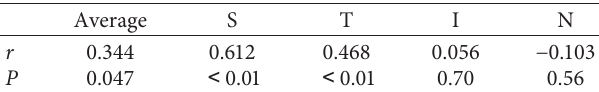
Figure 2: (a) RNFL thickness in each quadrant of the preclinical DR group and control group. (b) Vessel density in each quadrant of the preclinical DR group and control group. Table 4: Correlations between vessel density and RNFL.